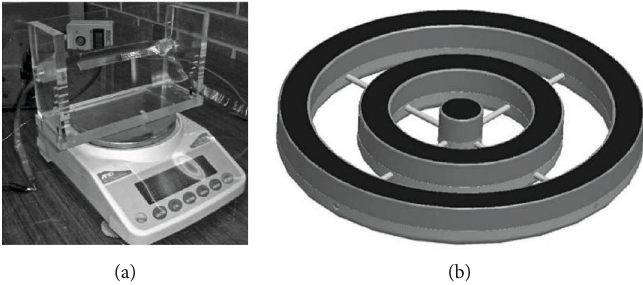
Figure 20: APT products: (a) experimental rig and balance; (b) computer model of plasma thruster prototype